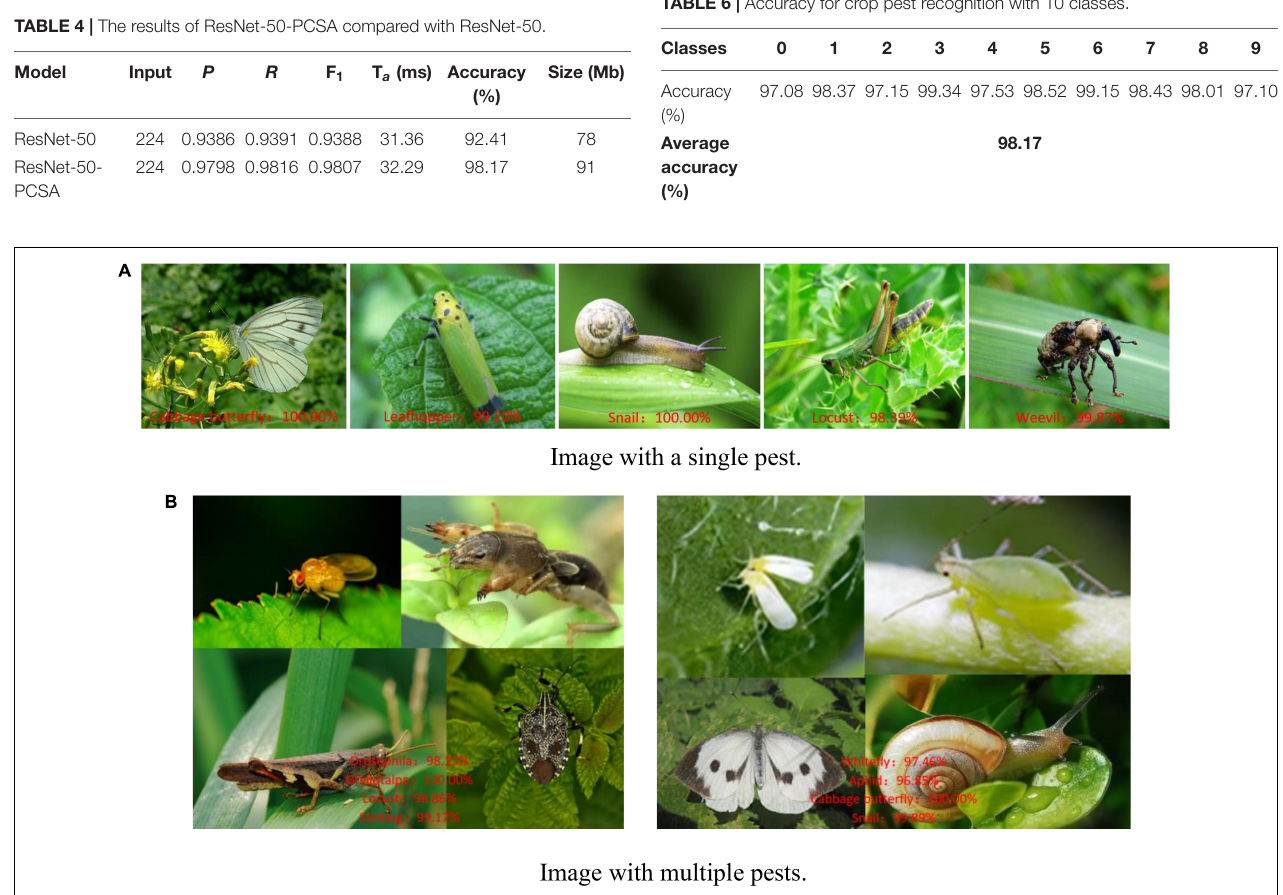
Frontiers in Plant Science |